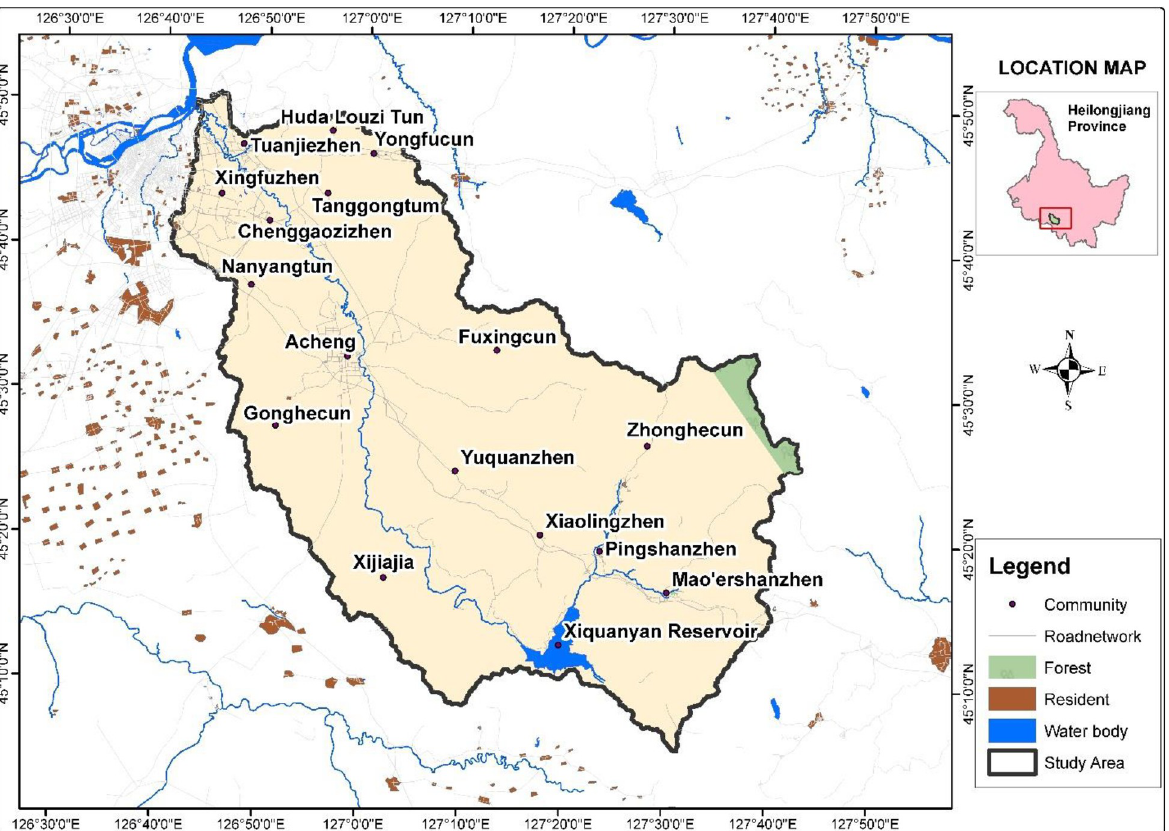
Fig 1. Ashi River Watershed located in the south-west of Heilongjiang